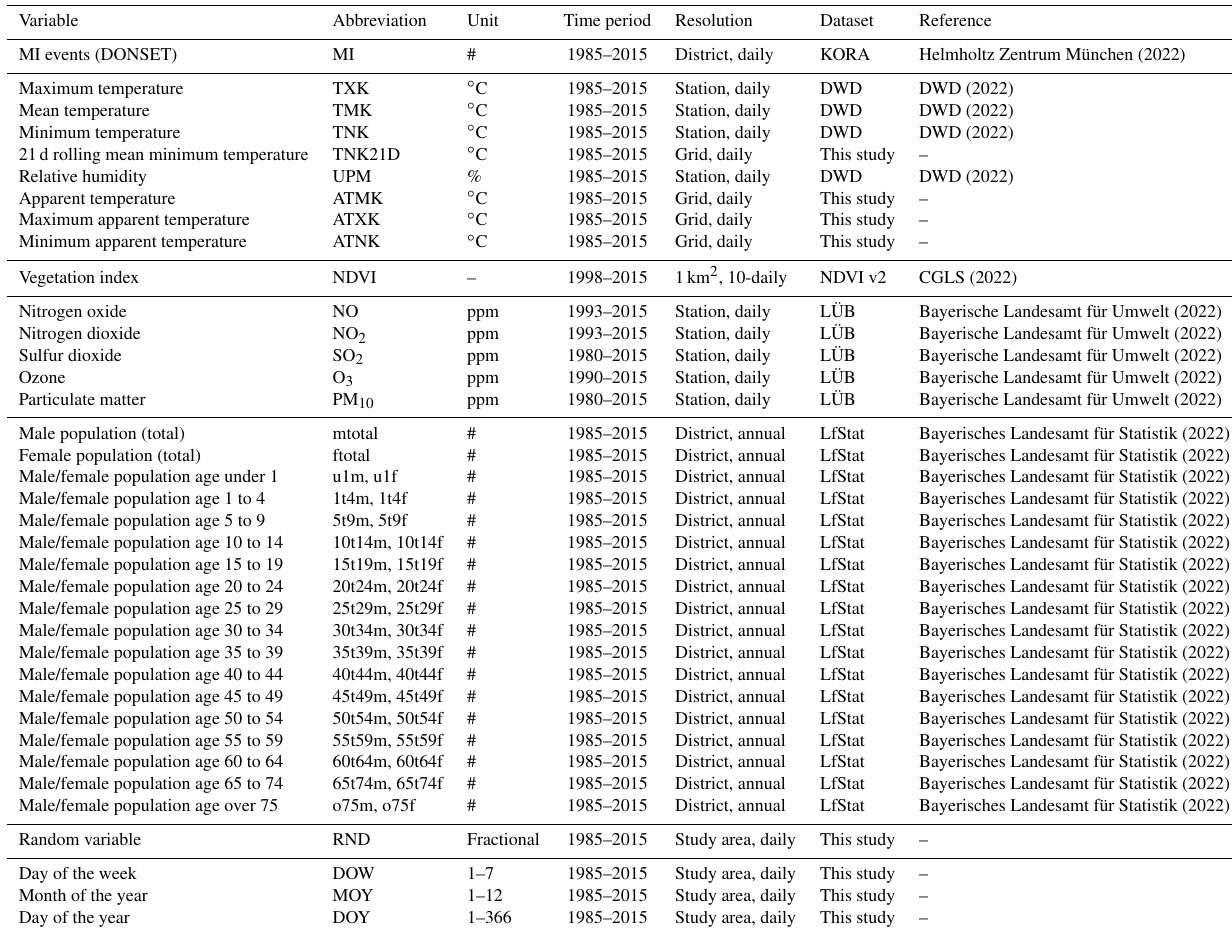
Table 3. Overview of predictive variables, source datasets and their